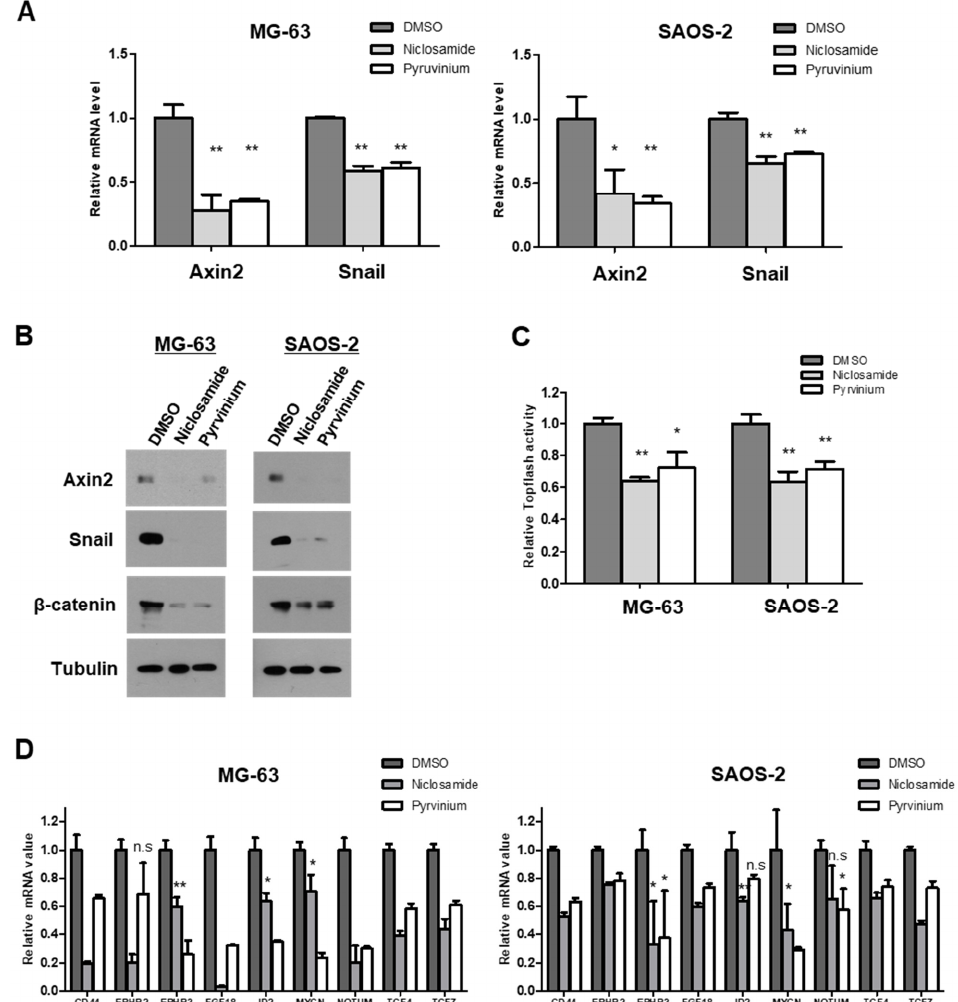
Figure 3. Niclosamide and pyrvinium attenuate the activities of Wnt/Axin2/Snail axis. ( A ) Axin2 and Snail mRNA level in MG-63 and SAOS-2 cells. The transcript abundance was determined by quantitative RT-PCR. ( B ) Western blot analysis of osteosarcoma cells treated with 0.25 μ M niclosamide and 0.03 μ M pyrvinium. Tubulin served as a loading control. Representative images are shown from at least two independent experiments. ( C ) Relative luciferase activity representing β -catenin/TCF-dependent transcription in treated cells. Osteosarcoma cells were transiently transfected with the TOPFlash luciferase construct and SV40 Renilla-expression vector in each well. After 24 h of incubation, cells were treated with 0.25 μ M niclosamide and 0.03 μ M pyrvinium. Luciferase activity was measured 24 h later with normalization to the activity of SV40 Renilla. ( D ) mRNA levels of β -catenin target genes by quantitative RT-PCR. The value of sample was normalized to the levels of GAPDH mRNA. Quantitative RT-PCR experiments were carried out in triplicate (error bars, ±SD. * p < 0.05, ** p < 0.01 versus DMSO, n.s., not significant).